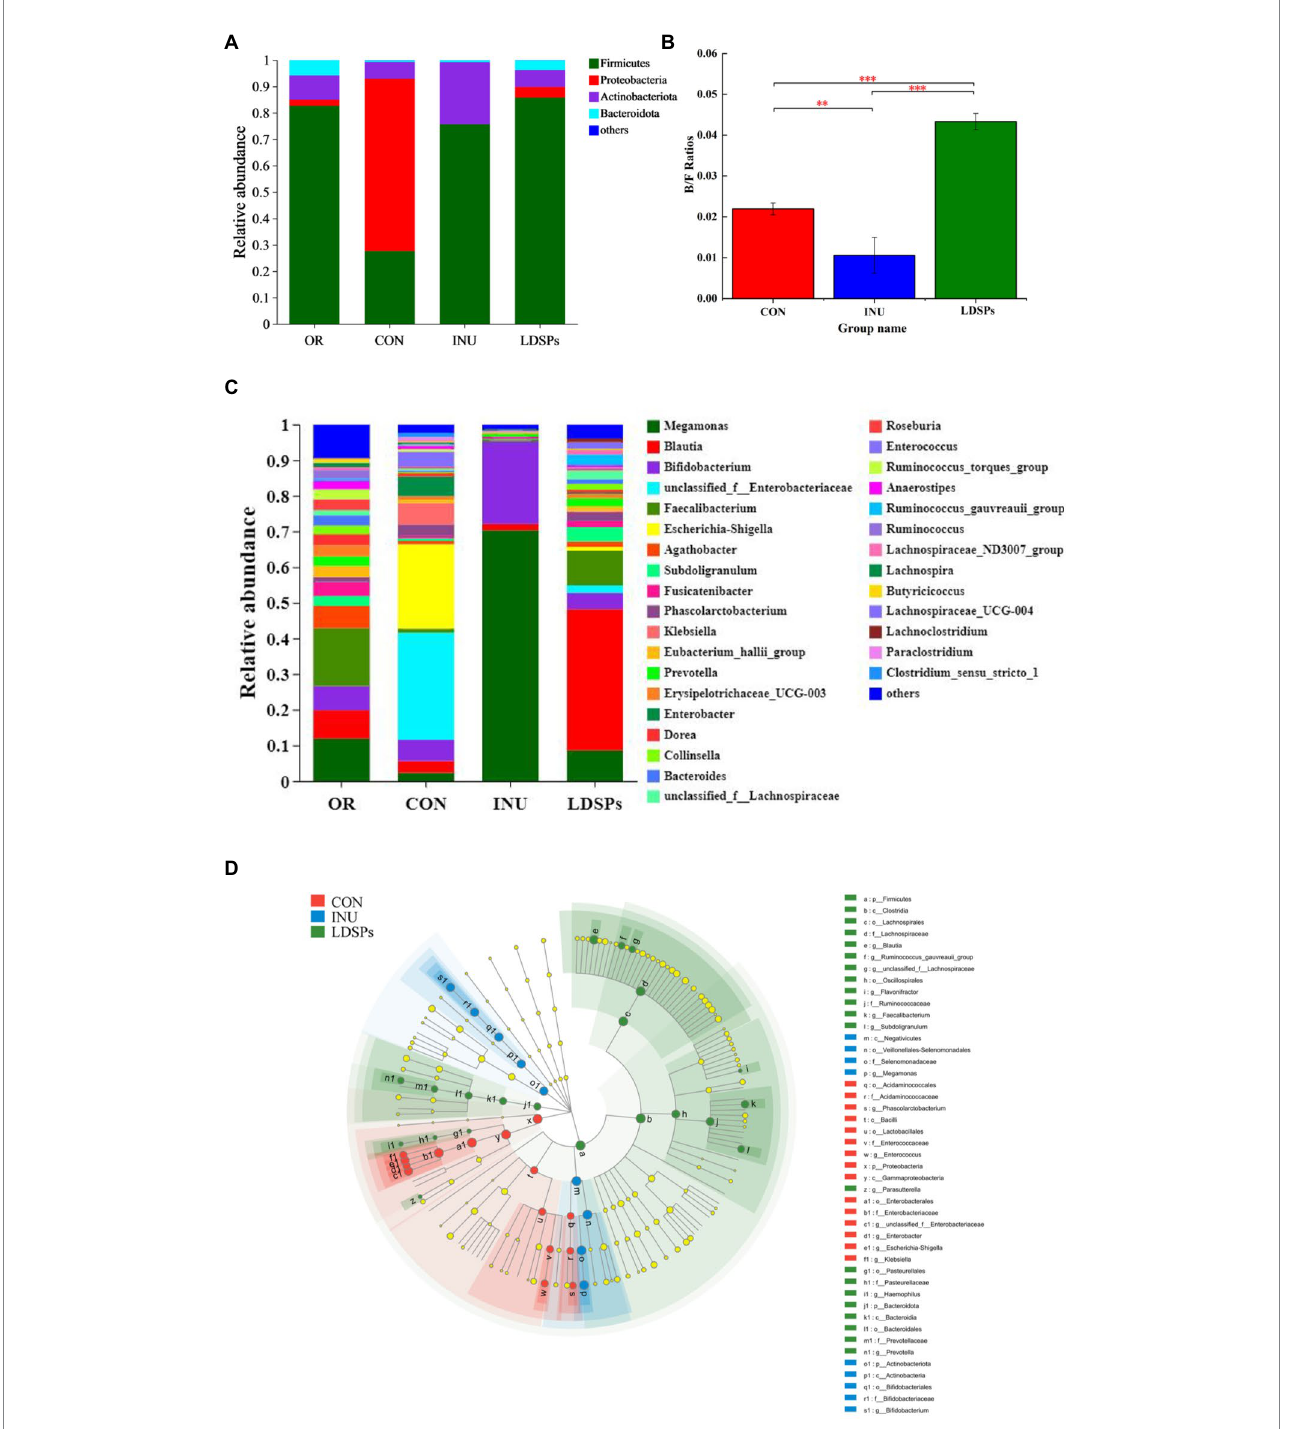
FIGURE 3 Relative abundance of gut microbiota community at the phylum (A) and genus (C) levels, Bacteroidetes/Firmicutes (B/F) ratios (B) , and the comparison of microbiota from phylum level to genus level among the CON, INU, and LDSPs groups based on linear discriminant analysis effect size (LEfSe; D ) after 24 h of fermentation. * p < 0.05, ** p < 0.01, and *** p < 0.001, respectively; OR, the initial sample group, CON, the blank control (no additional carbon source supplement), INU, the positive control (INU supplement), and LDSPs, the experimental group (LDSPs